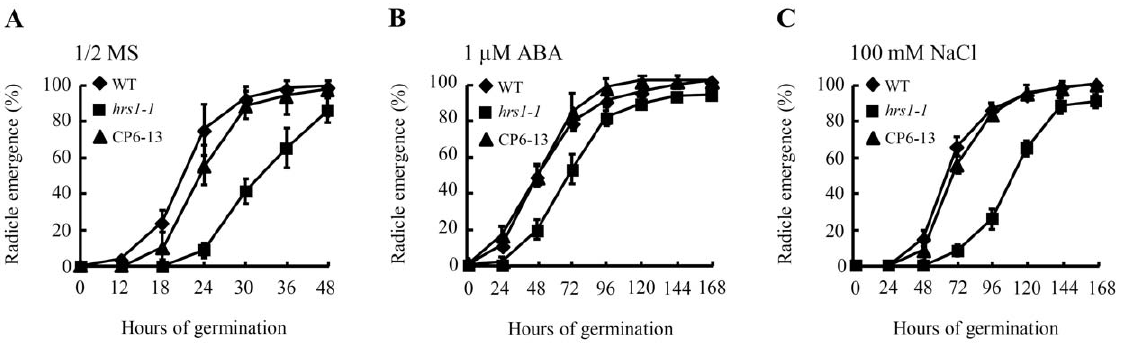
Figure 1. Germination defects of HRS1 knockout mutant on different media. The seeds of wild type (WT) control, HRS1 knockout mutant ( hrs1-1 ) and complementation (CP) line (CP6-13) were stratified for 48 h at 4 u C, followed by transfer to 23 u C to allow germination to start on 1/2 MS medium or those supplemented with the indicated concentrations of abscisic acid (ABA) or NaCl. (A–C) The germination time courses of WT, hrs1-1 and CP genotypes on 1/2 MS medium or those containing 1 m M ABA or 100 mM NaCl. The percentages of radicle emergence (means 6 SD) at the indicated time points were each determined using the results from triplicate samples. The data shown are all typical of five separate germination experiments, and the two additional CP lines (CP19-1 and CP23-3) behaved similarly as CP6-13 during the experiments. HOG, hours of germination at